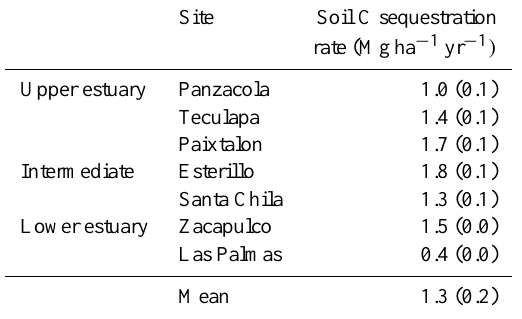
Table 7. Soil carbon (C) sequestration rates (MgCha − 1 yr − 1 ) of mangroves within La Encrucijada Biosphere Reserve,